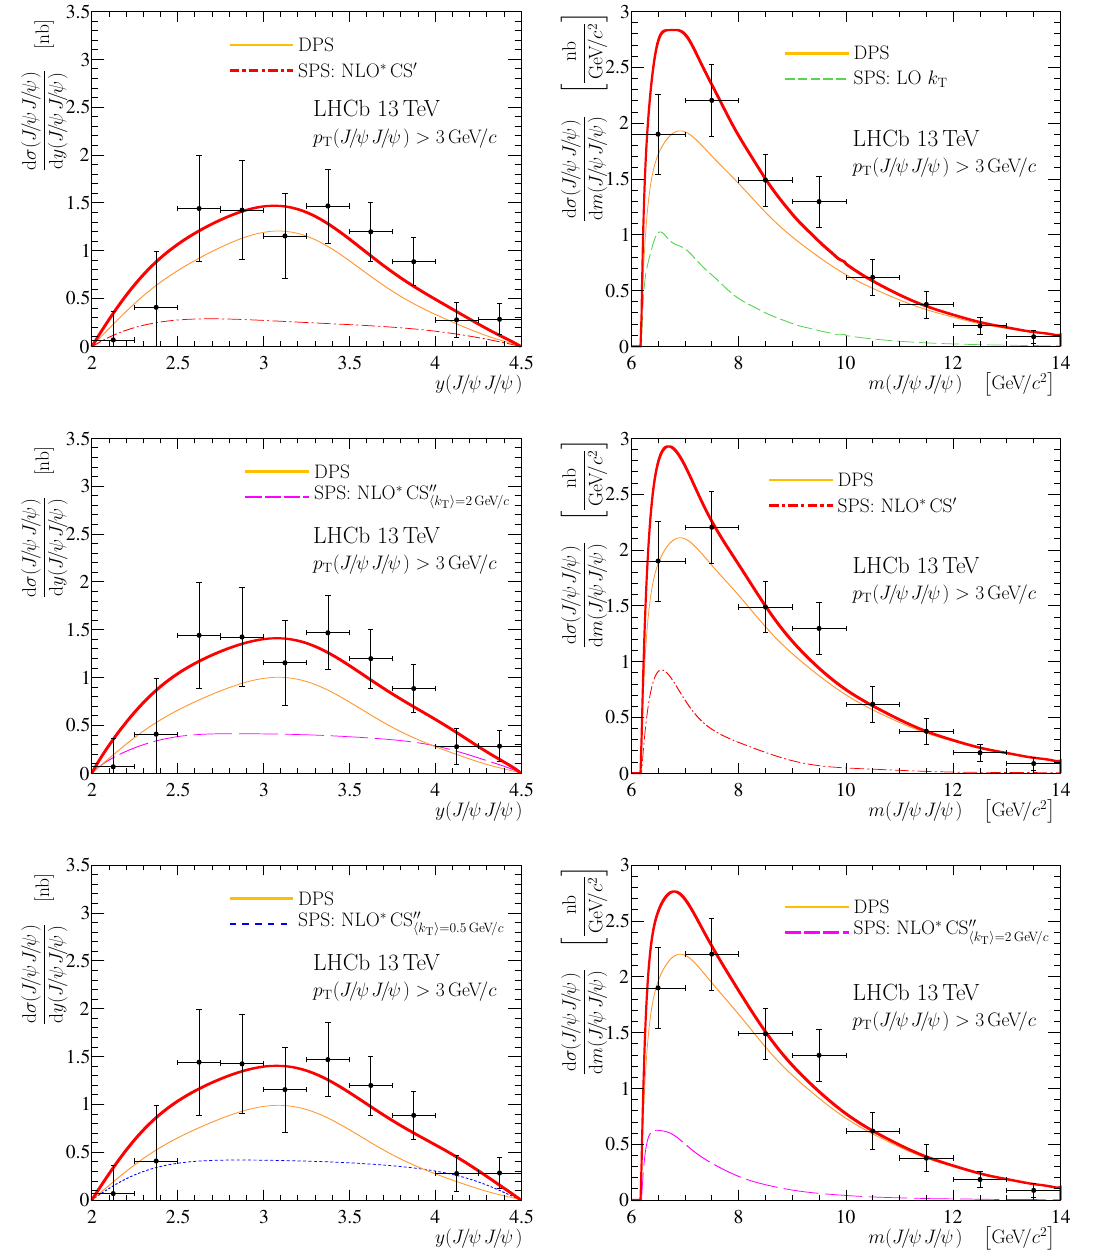
Figure 14. Result of templated DPS (cid:12)t for d (cid:27) ( J= J= ) 3 GeV =c region. The (black) points with error bars represent the data. The total (cid:12)t result is shown with the thick (red) solid line and the DPS component is shown with the thin (orange) solid line.